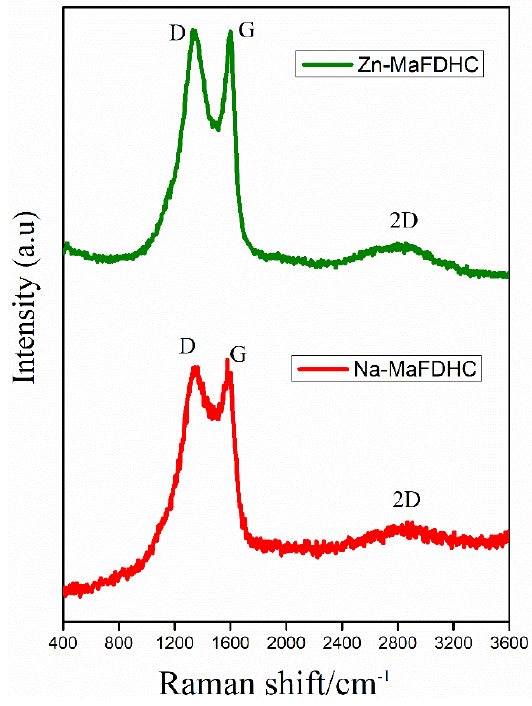
Figure 3. RAMAN spectra of Na − MaFDHC and Zn − MaFDHC